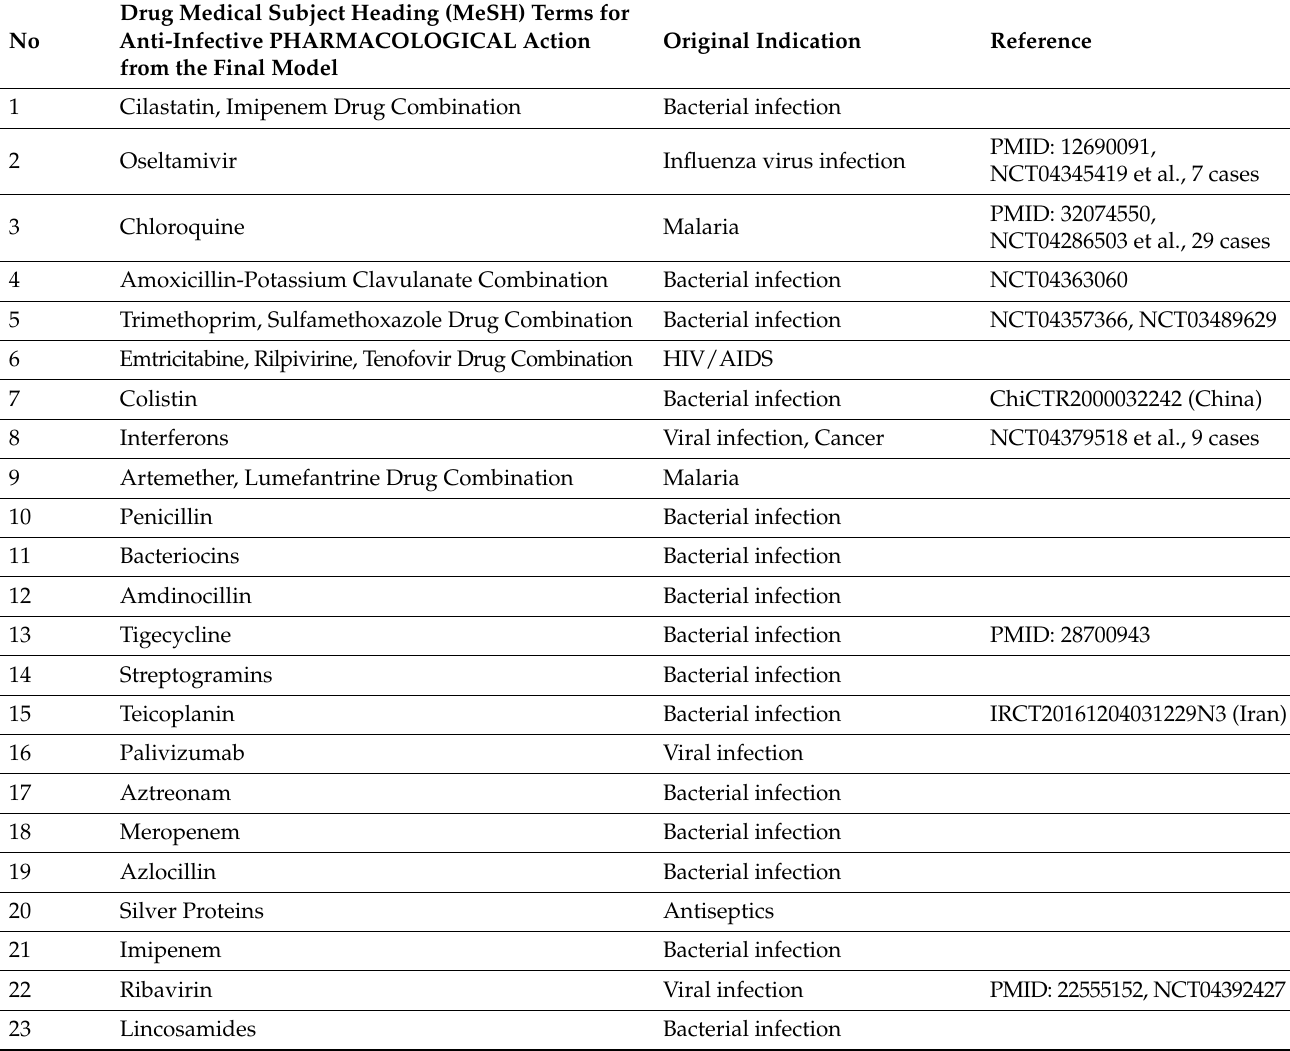
Table 3. List of drugs extracted from the final model with high relevance to